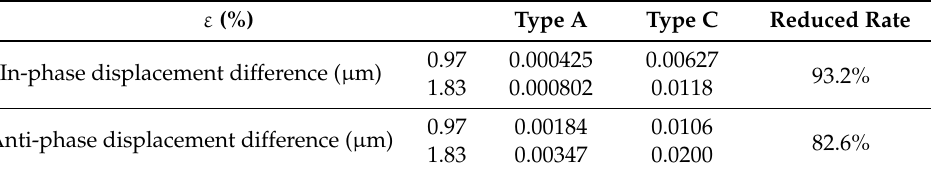
Table 6. Comparisons of displacement difference in analytical values of Type A and Type